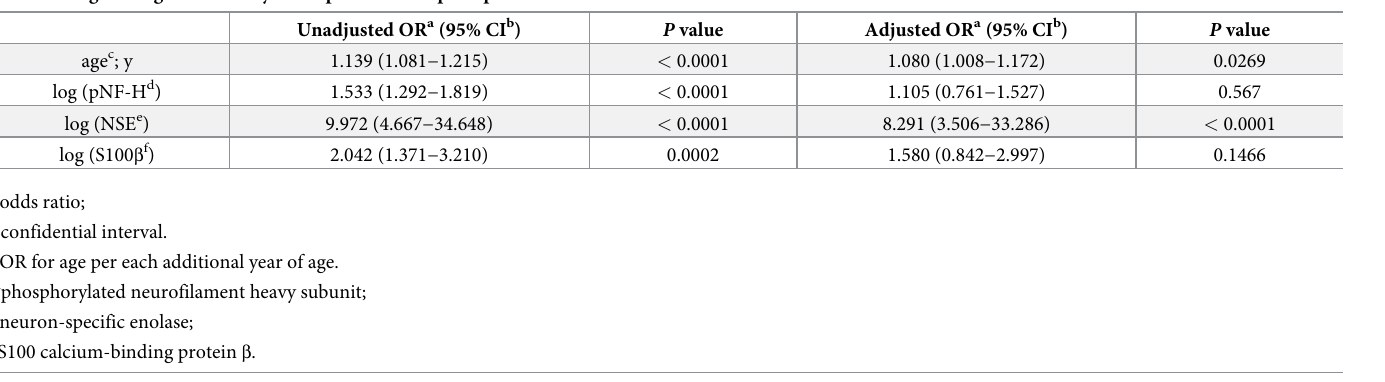
Fig 3. Receiver operating characteristic curves analysis of serum biomarker levels for the diagnosis of postoperative delirium. NSE, neuron-specific enolase; S100 β , S100 calcium-binding protein β . https://doi.org/10.1371/journal.pone.0259217.g003 Table 2. Logistic regression analysis for prediction of postoperative delirium.